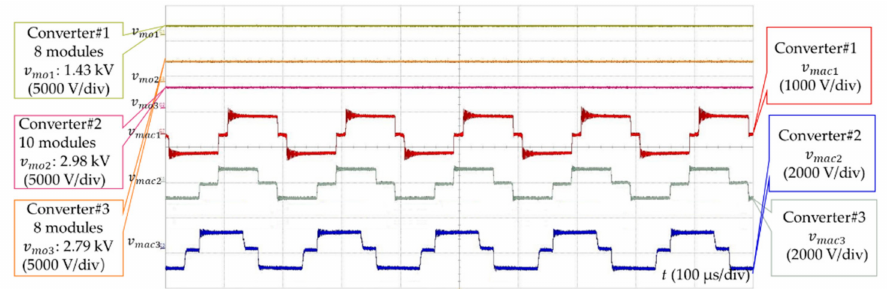
Figure 29. Modules waveform under extreme different irradiance.